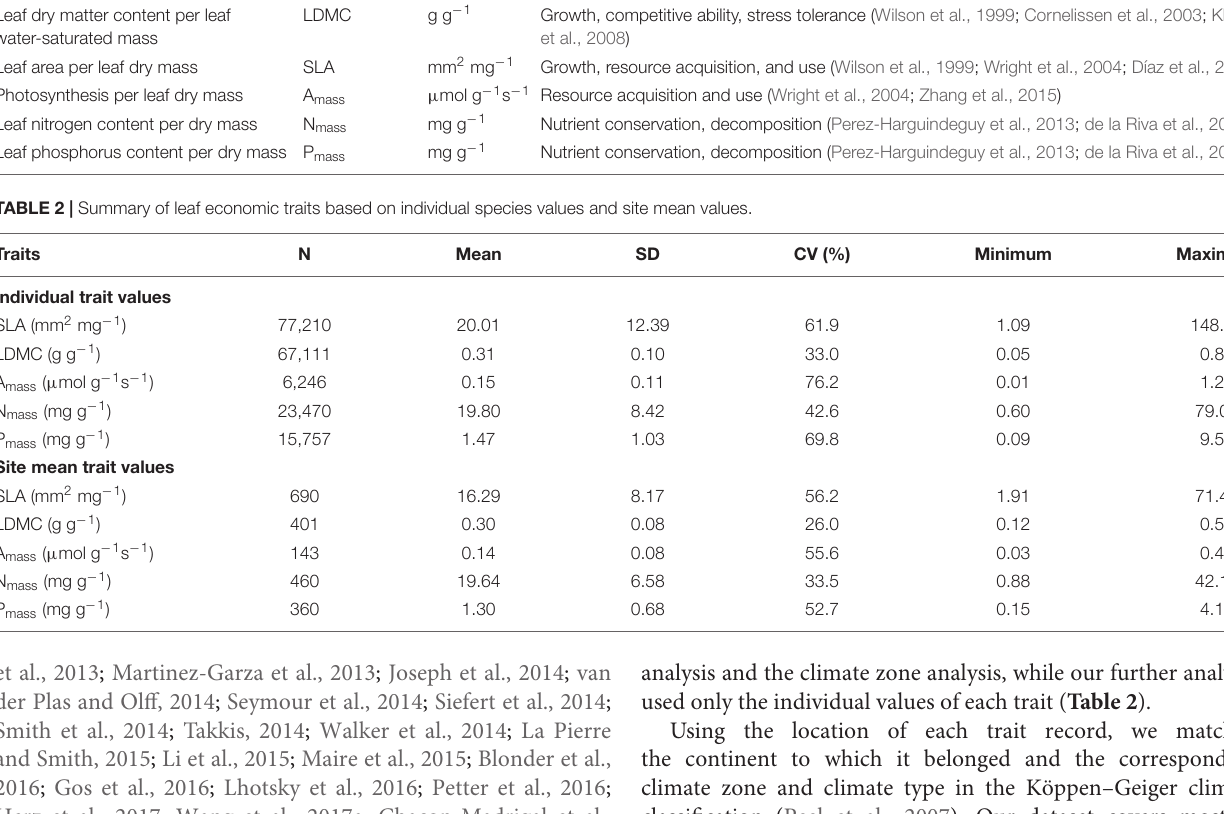
TABLE 1 | List of leaf traits selected for this study, their abbreviations, functional significance, and related references. Traits Abbreviations Unit